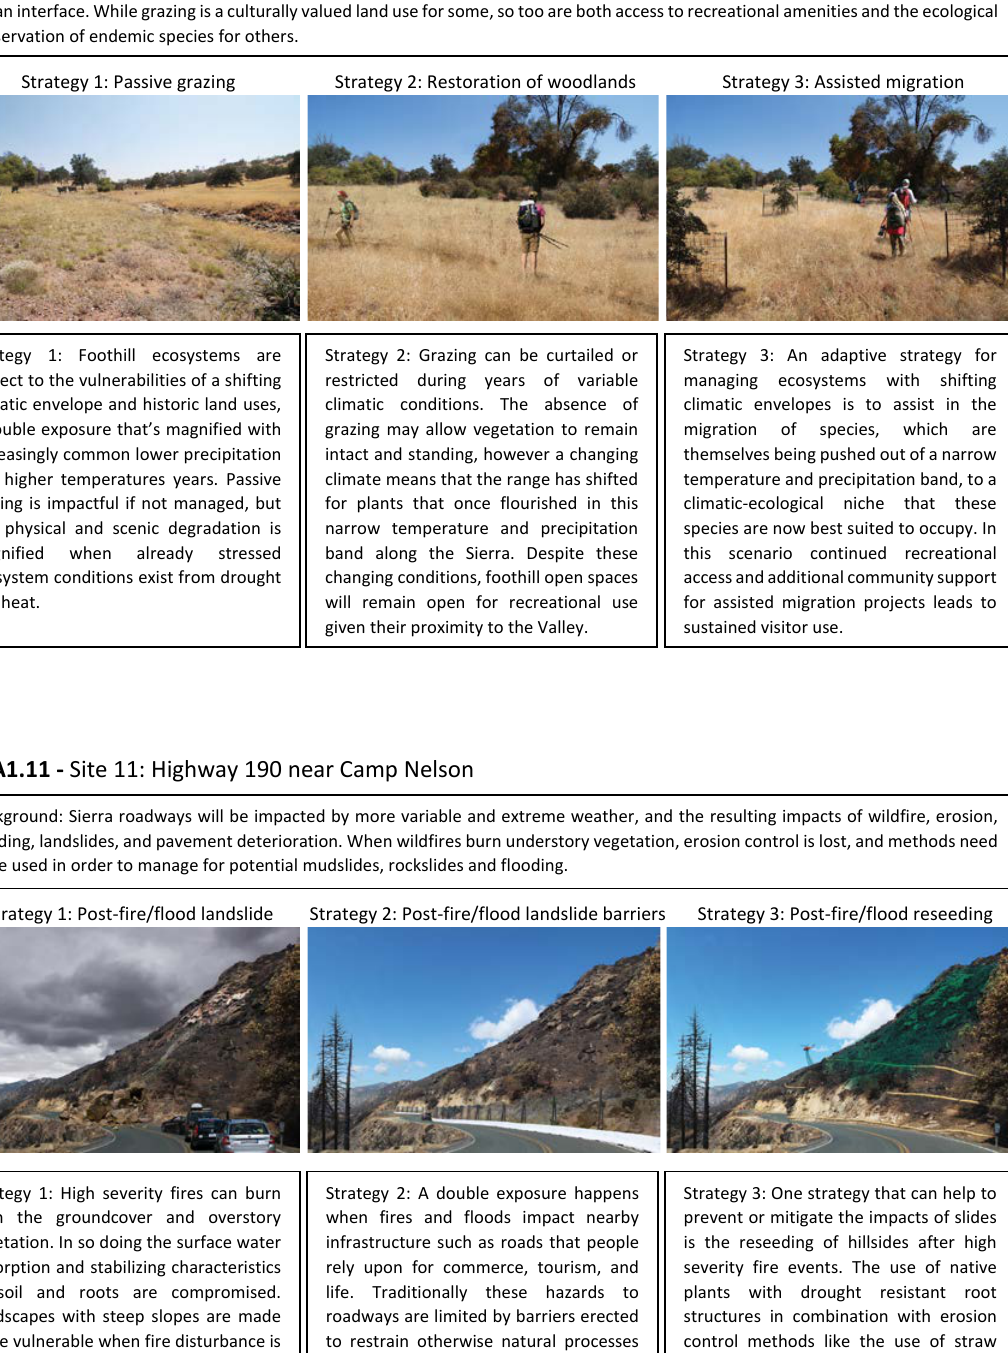
Fig. A1.10 - Site 10: Table Mountain Preserve